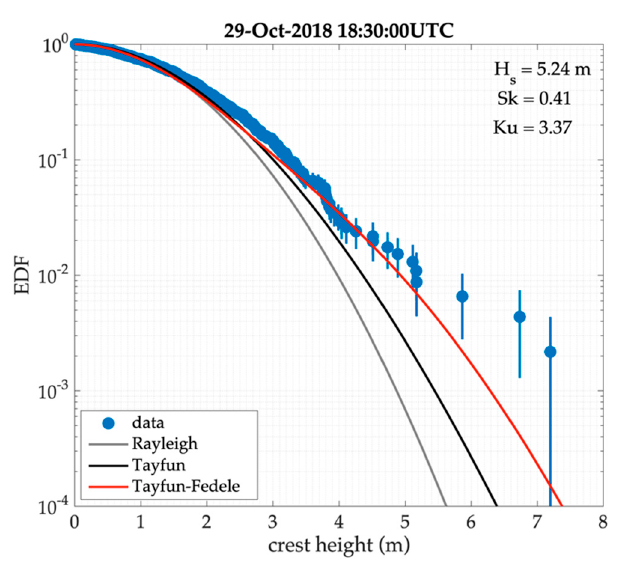
Figure 6. Crest height distribution (one-hour record) at the peak of the 29 October 2018 storm. See Figure 5 for the measurement location.